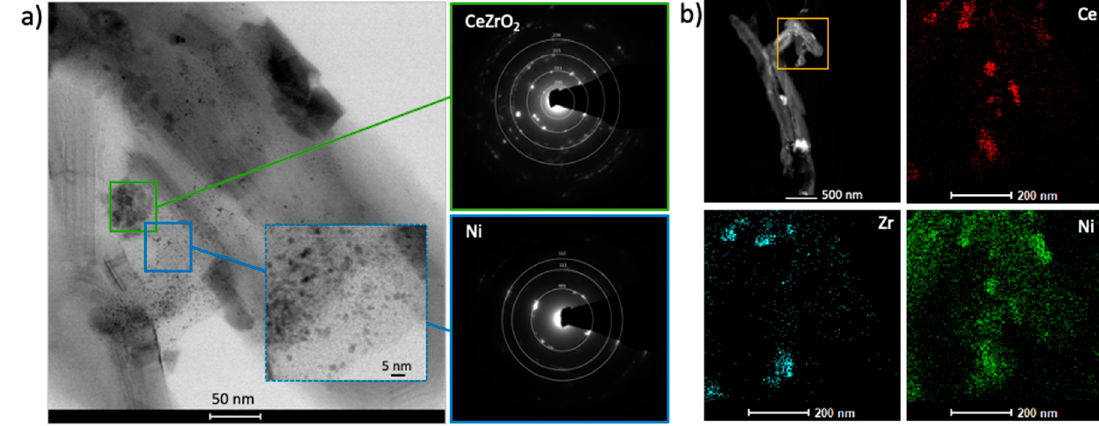
Figure 2. Bright field transmission electron microscopy (TEM) with selected area electron diffraction (SAED) ( a ) and ele- mental mapping for C, Ce and Zr ( b ) in CZ/CFF sample.